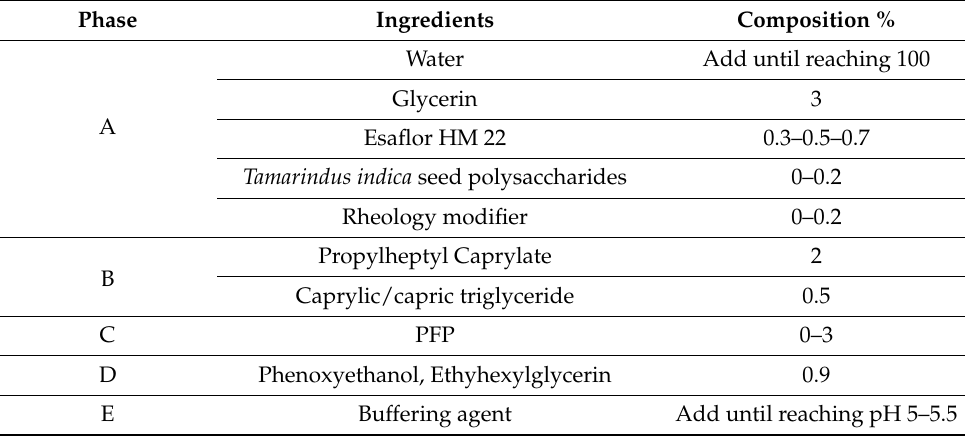
Table 2. Reference formula for gel–cream